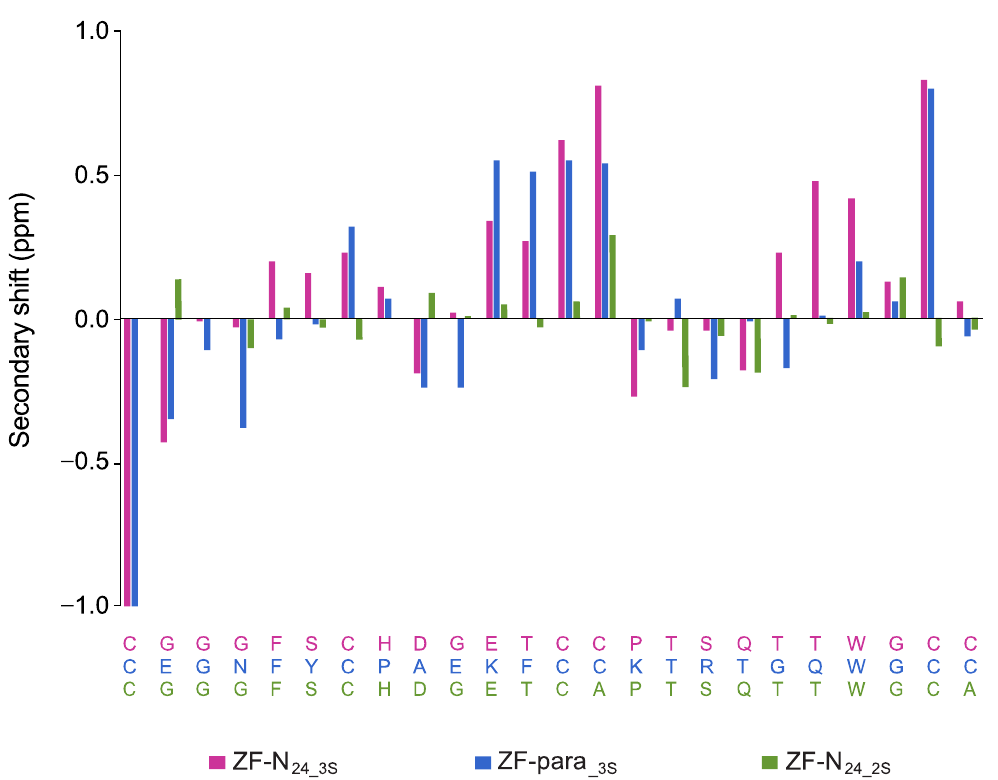
Figure 3. αH secondary-shift comparison for truncated granulin analogues. The αH secondary shifts were calculated by subtracting the random coil 1 H NMR chemical shifts previously reported by Wishart et al. [28] from the experimental αH chemical shifts. The sequences of ZF-N 24_3s (violet), ZF-para _3s (blue) and ZF-N 24_2s (green) are given at the bottom of the diagram and are colour coded with respect to the graph.